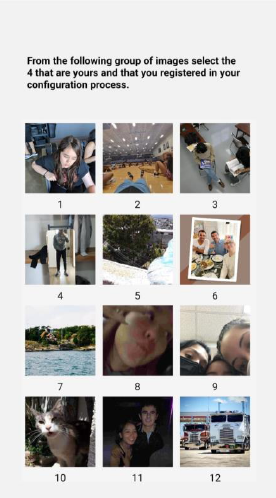
Figure 7. Image-Selection screen.